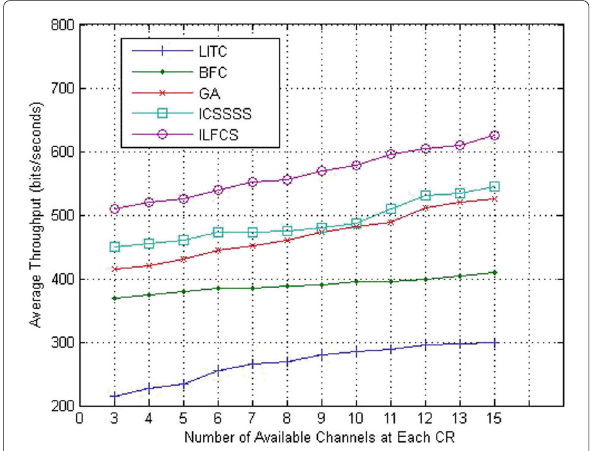
Fig. 15 Spectrum opportunity utilization under different numbers of available channels. The results of different simulation experiments to measure spectrum opportunity utilization at different numbers of available channels for the BFC, LITC, GA, ICSSSS and the ILFCS are shown